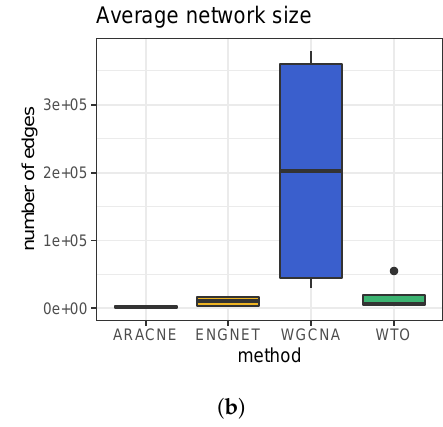
Figure A11. ( a ) Comparison of the average area under the ROC curve (AUC) for the four reconstruction methods under comparison across the four used datasets. On average, EnGNet outperformed the other three methods in terms of AUC. ( b ) Size comparison of the inferred networks. EnGNet exhibited competitive results in terms of network size, providing considerably sparser networks than